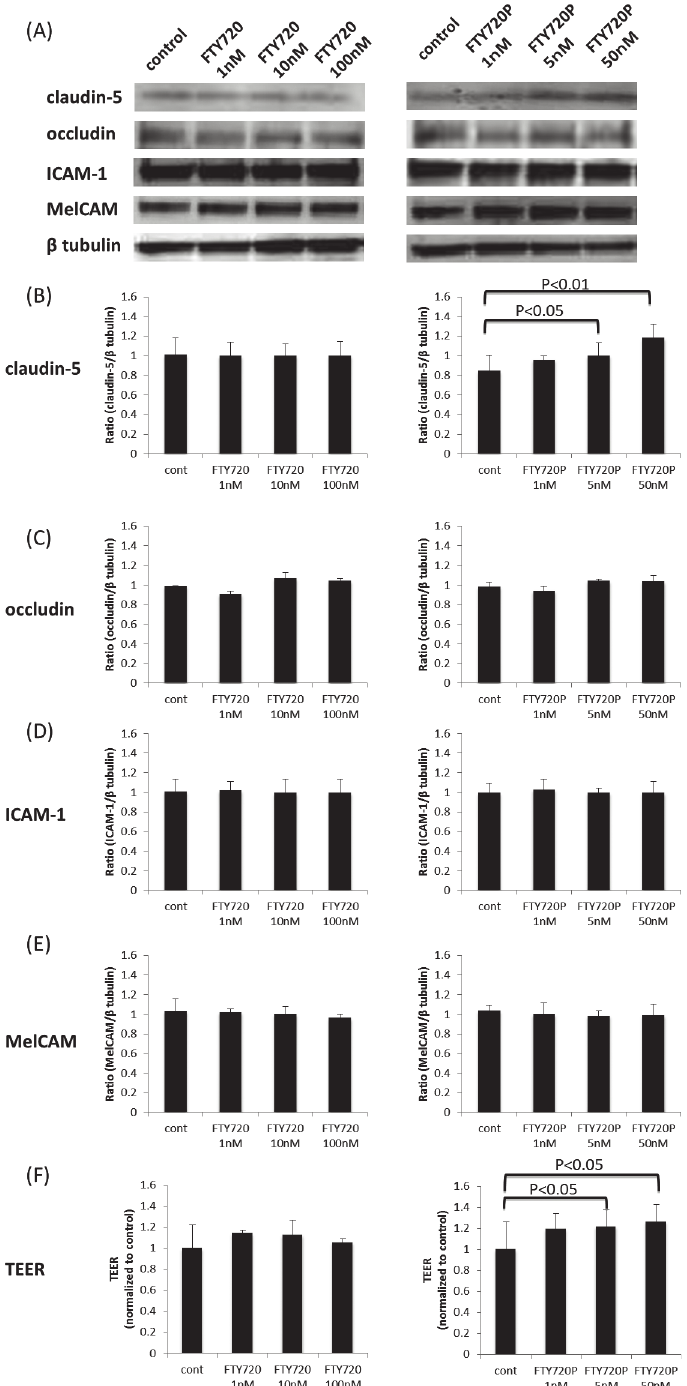
Fig 1. The effects of fingolimod and fingolimod-phosphate on BMECs. (A) The effects of fingolimod and fingolimod-phosphate on tight junction proteins, such as claudin-5 and occludin, and adhesion molecules, including ICAM-1 and MelCAM, in the human brain microvascular endothelial cells (BMECs) were measured using a Western blot analysis. (B)(C)(D)(E) Each bar graph reflects the combined densitometry data for the independent experiments. Treatment with fingolimod-phosphate increased the claudin-5 protein levels (B) and TEER values in the BMECs in a dose-dependent manner (F).